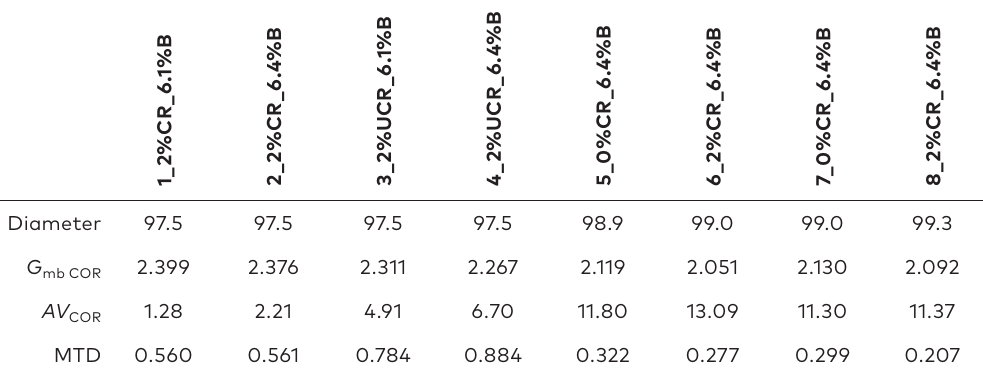
Table 5. Results for volumetric tests and